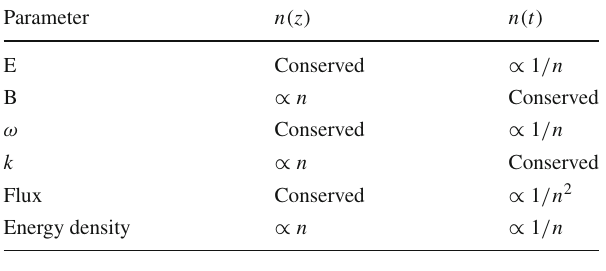
Table 1 Summary of the main properties of an electromagnetic wave propagating in a space dependent n ( z ) or a time dependent n ( t ) refrac- tive